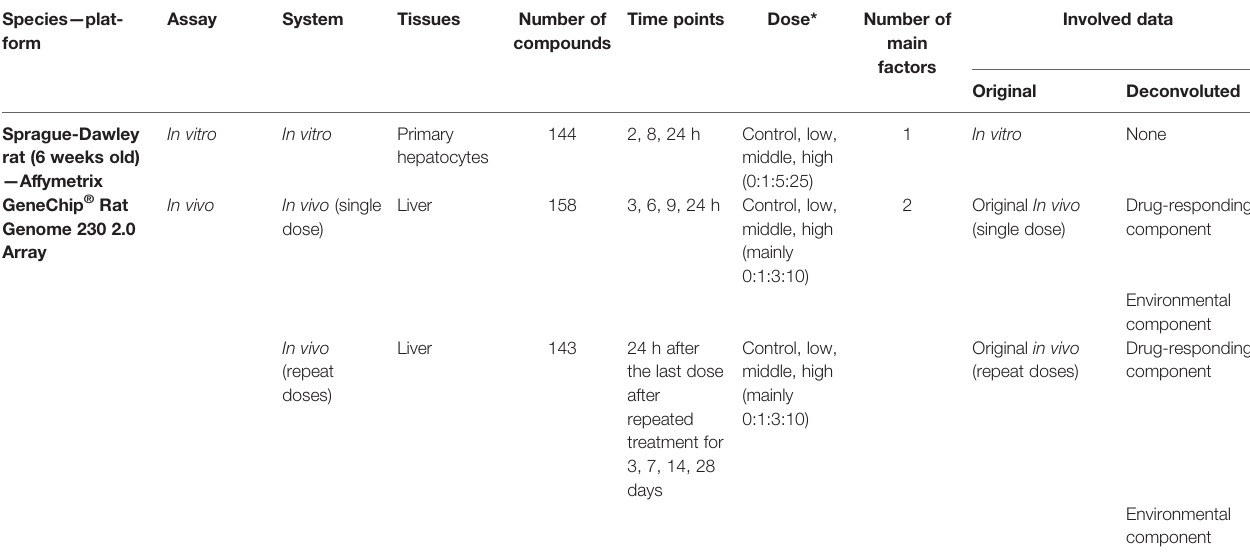
TABLE 1 | Data information and usage in this